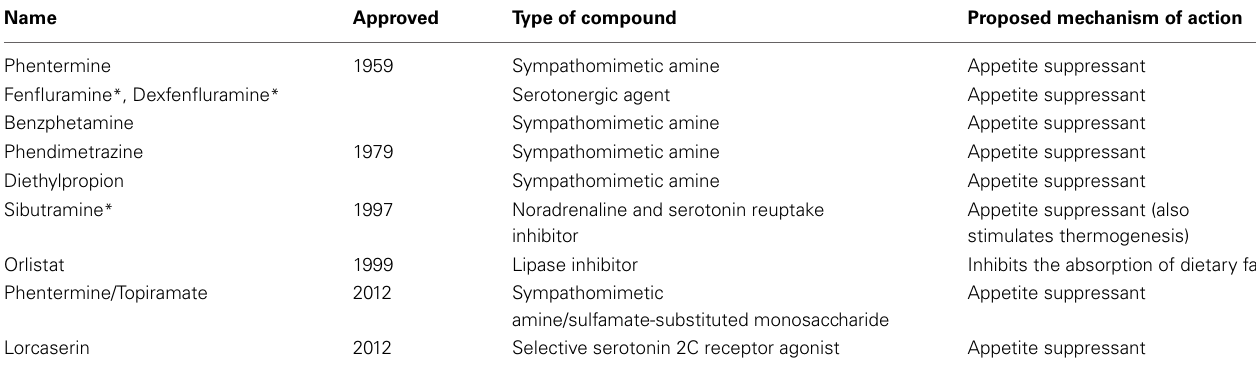
Table 1 | Current pharmaceutical treatments of